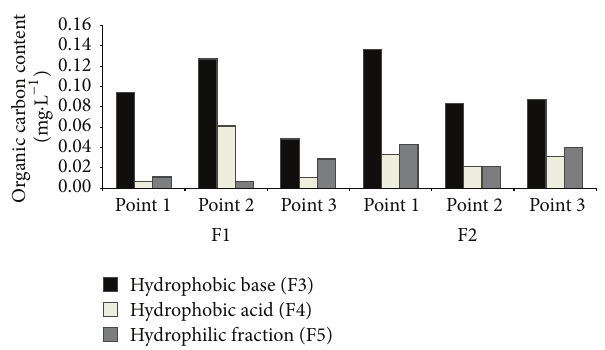
Figure 3: Organic carbon content of F1 and F2 fractionated by